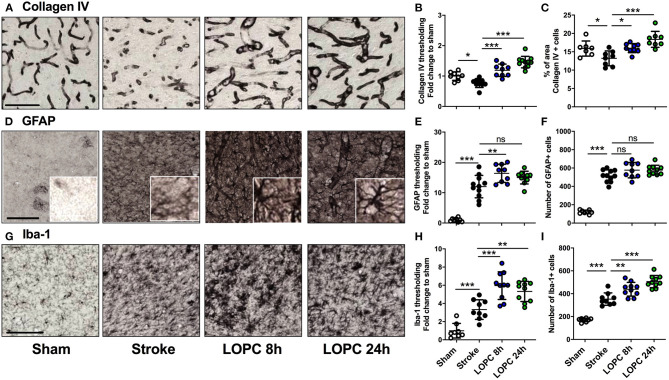
The effects of LOPC on vasculature and glial cells within the peri-infarct region. The four left panels in each row illustrate representative labeling for each marker investigated (A) Collagen IV, (D) GFAP (insets show astrocyte morphology at higher magnification) and (G) Iba-1 for the four groups: sham, stroke, LOPC 8 h, and LOPC 24 h. The first row of graphs (B, E, H) show quantification of the fold change of thresholded material for each of the markers. The second row of graphs show (C) percentage of area covered by Collagen IV positive cells, and number of (F) GFAP positive cells and (I) Iba-1 positive cells. Data is expressed as a fold change of mean ± SD for each group relative to the mean of the sham group. For cumulative threshold analysis refer to the Supplementary Figure 1. ns: not significant, *p < 0.05, **p < 0.01, ***p < 0.001 (ANOVA, Tukey's multiple comparisons). Black scale bars represent 100 μm and the white scale bar of inset represents 10 μm.